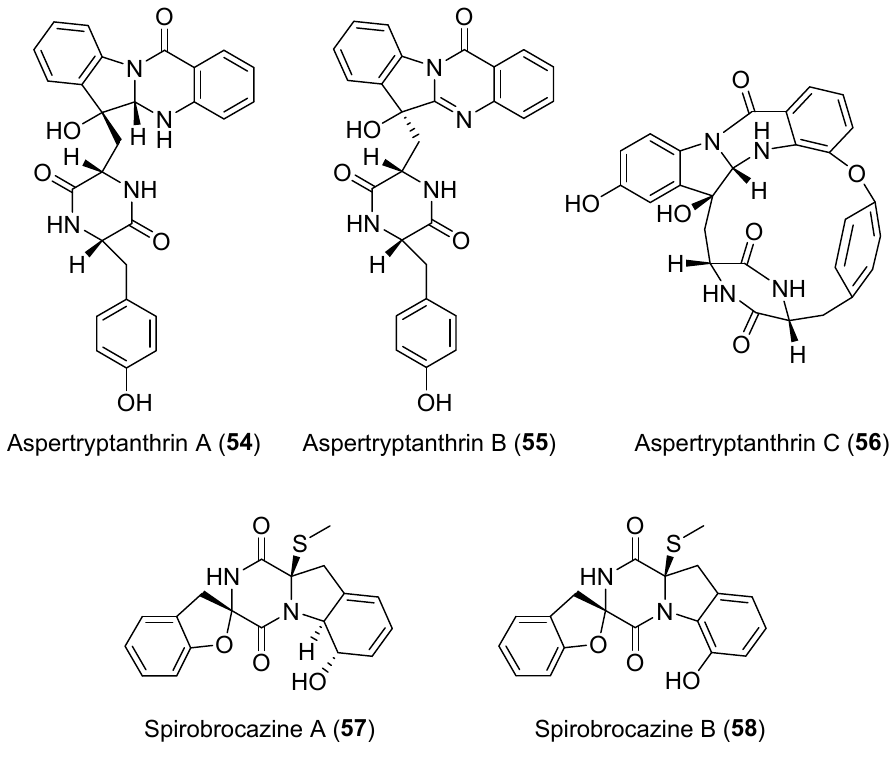
Figure 10. Structures of aspertryptanthrins A–C ( 54 – 56 ) and spirobrocazines A–B ( 57 – 58 ).